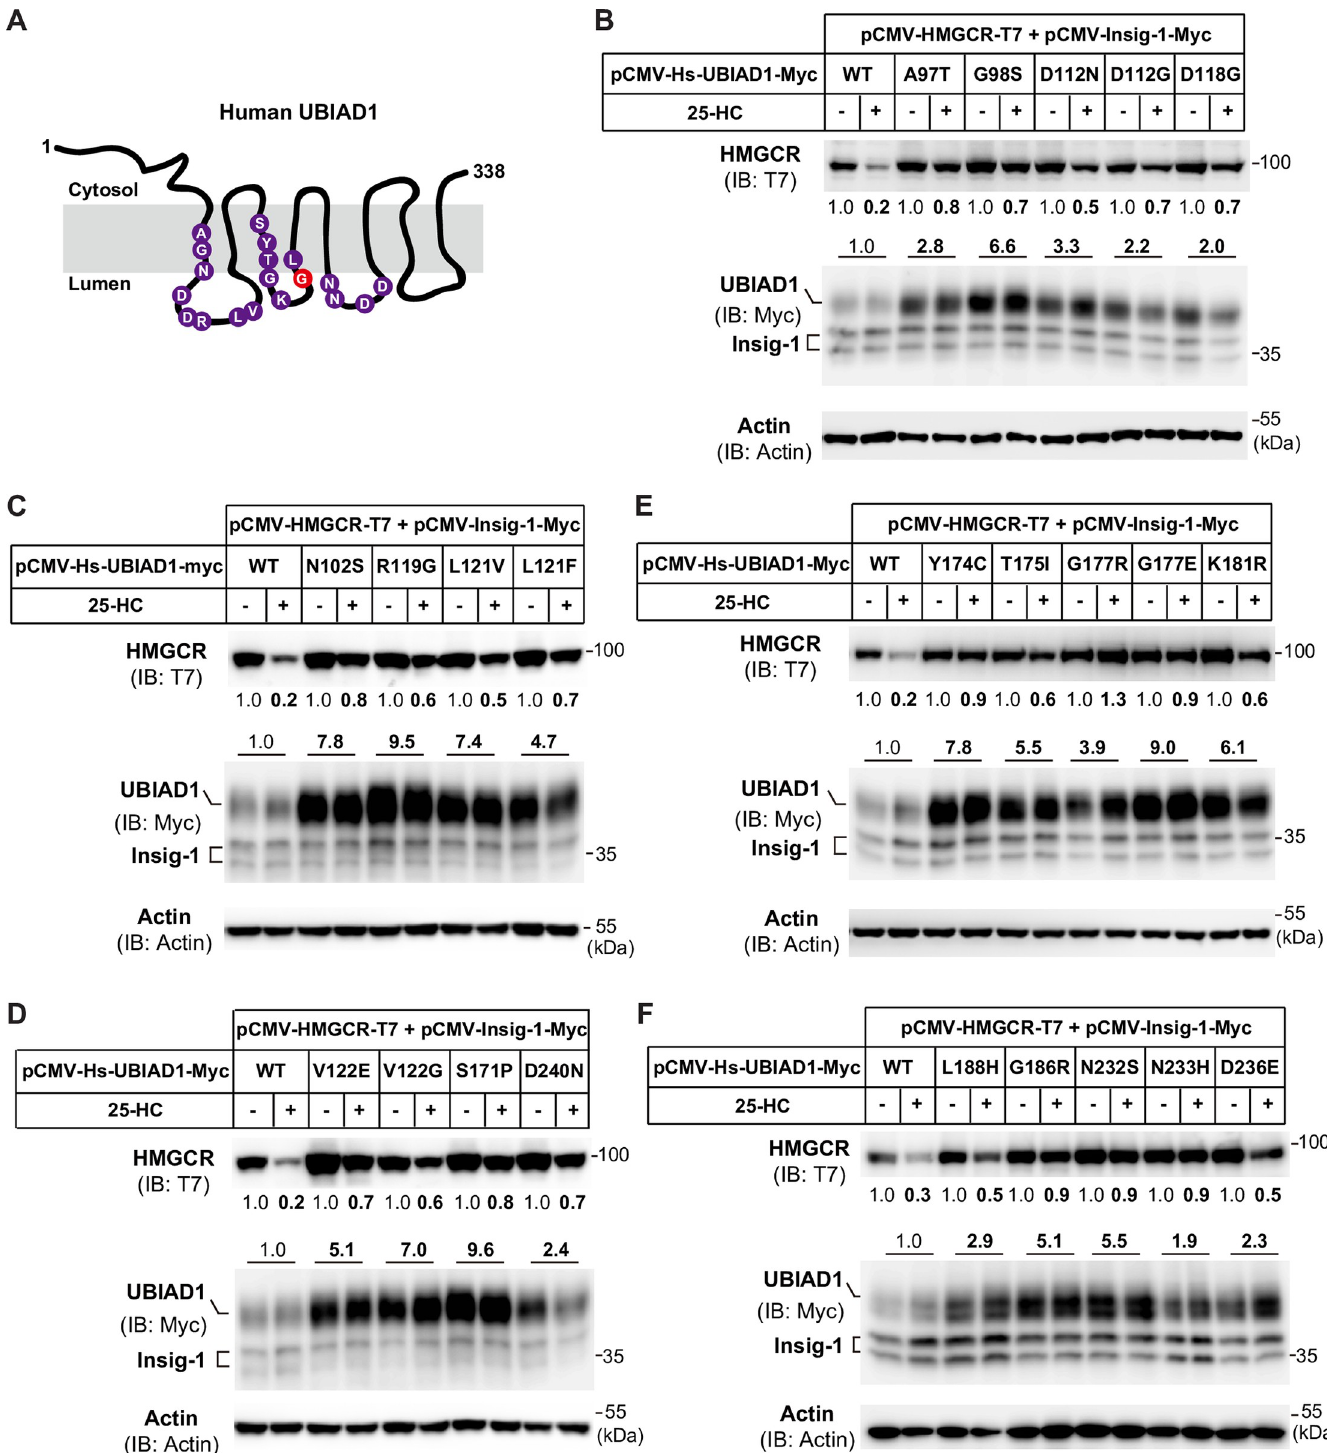
Fig 3. SCD-associated mutants of UBIAD1 block sterol-induced degradation of HMGCR. (A) Predicted topology of human UBIAD1 protein and SCD-associated mutations of amino acids. The G186R mutation of UBIAD1 is marked with red. There are 21 different nucleotide mutations occurred in the coding sequence that altered amino acids at 19 positions. Some residues of UBIAD1 were changed to 2 different amino acids, such as D112N, D112G, G177R, G177E, V122E and V122G. (B-F) Analysis of the effects of SCD-associated mutations of UBIAD1 on the degradation of HMGCR. CHO-K1 cells were set up in 60-mm dish and transfected with 1 μ g pCMV-HMGCR-T7, 0.03 μ g pCMV-Insig-1-Myc and 0.1 μ g indicated WT and mutant forms of pCMV-Hs-UBIAD1-Myc per dish. 6 hr after transfection, cells